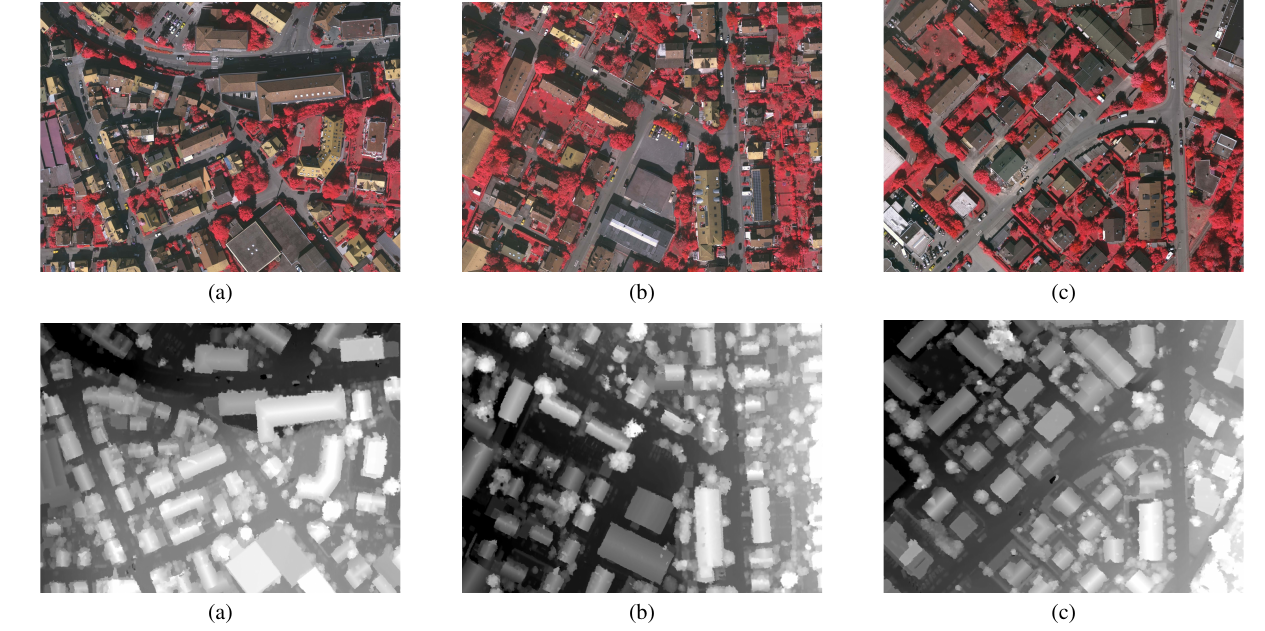
Figure 3. Example images and the corresponding DSMs used for performance